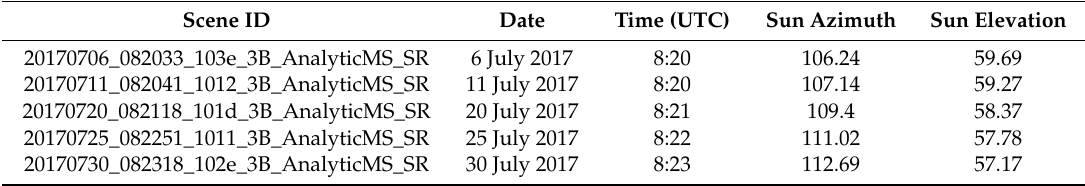
Figure 2. The selected daily images of the PlanetScope. All panels ( A – E ) share scale and north arrow. All maps share the same grid as of panel D. Table 1. The PlanetScope CubeSat images used in the